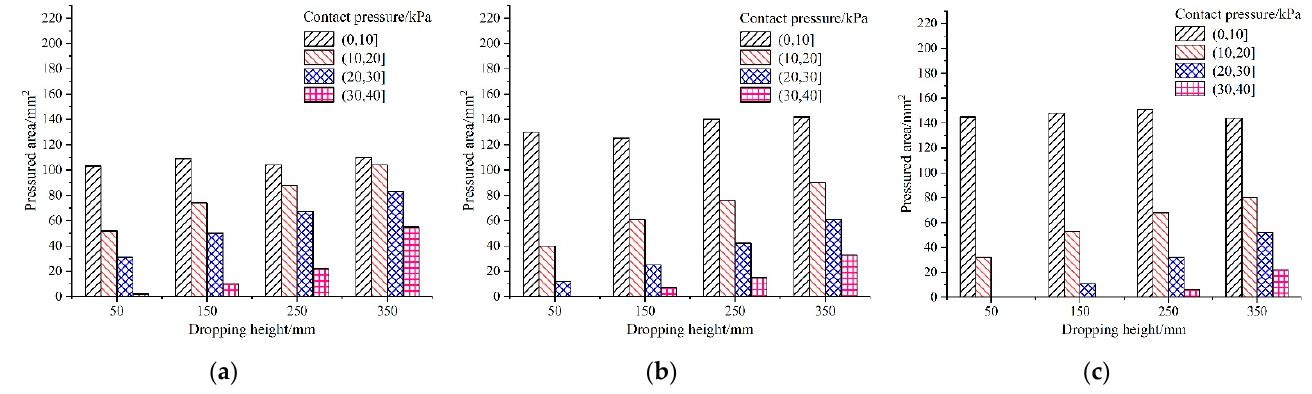
Figure 7. Pressure distribution contours at different drop heights for three collision materials.